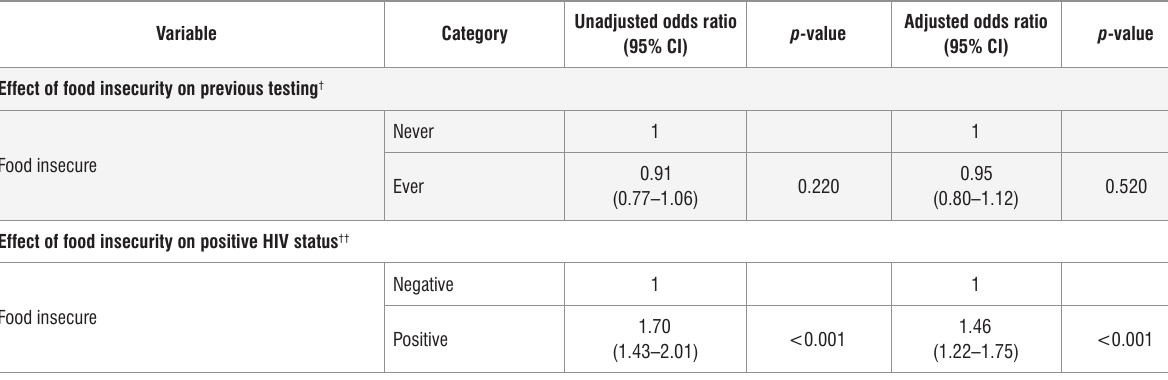
Table 2: Association between household food security and history of previous HIV testing, and testing HIV positive